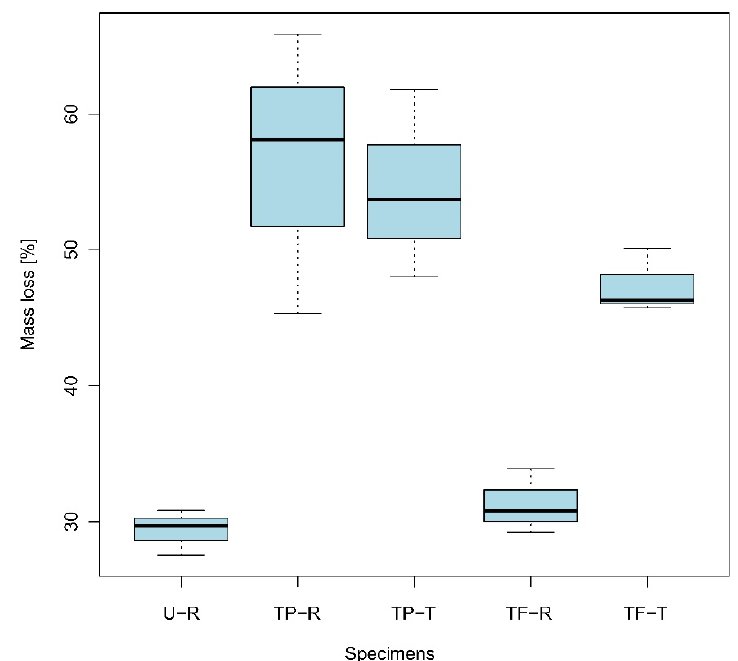
Figure 4. Boxplots of the mass loss of each specimen group at 780 s testing time.